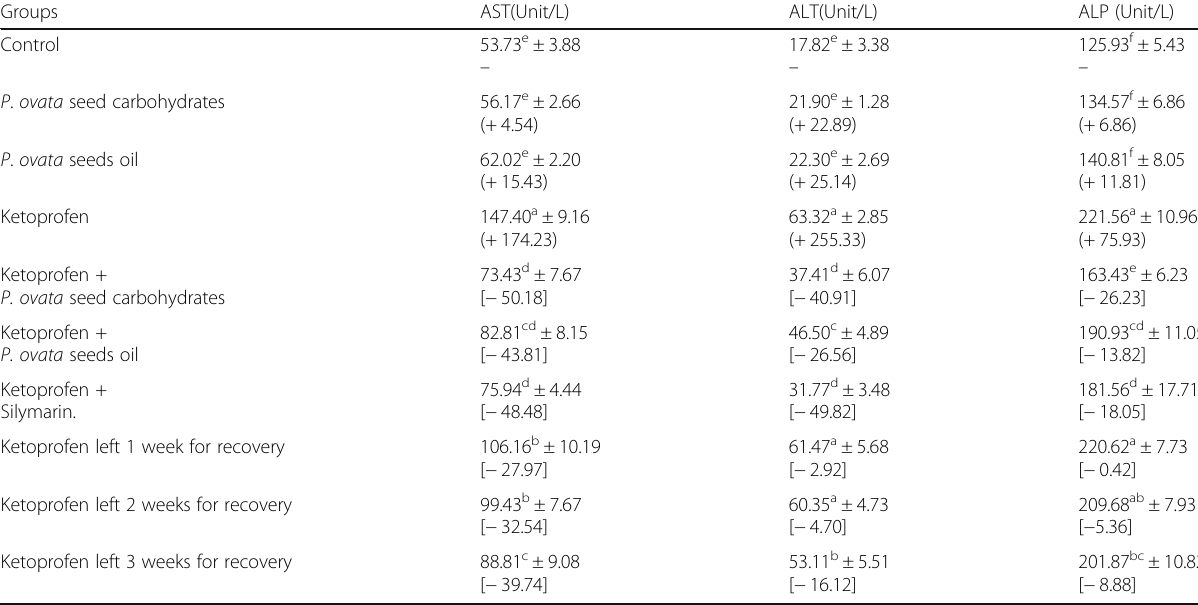
Table 6 Therapeutic effect of P . ovata seed carbohydrates and fixed oil on liver function enzymes of ketoprofen toxicity in rats Groups